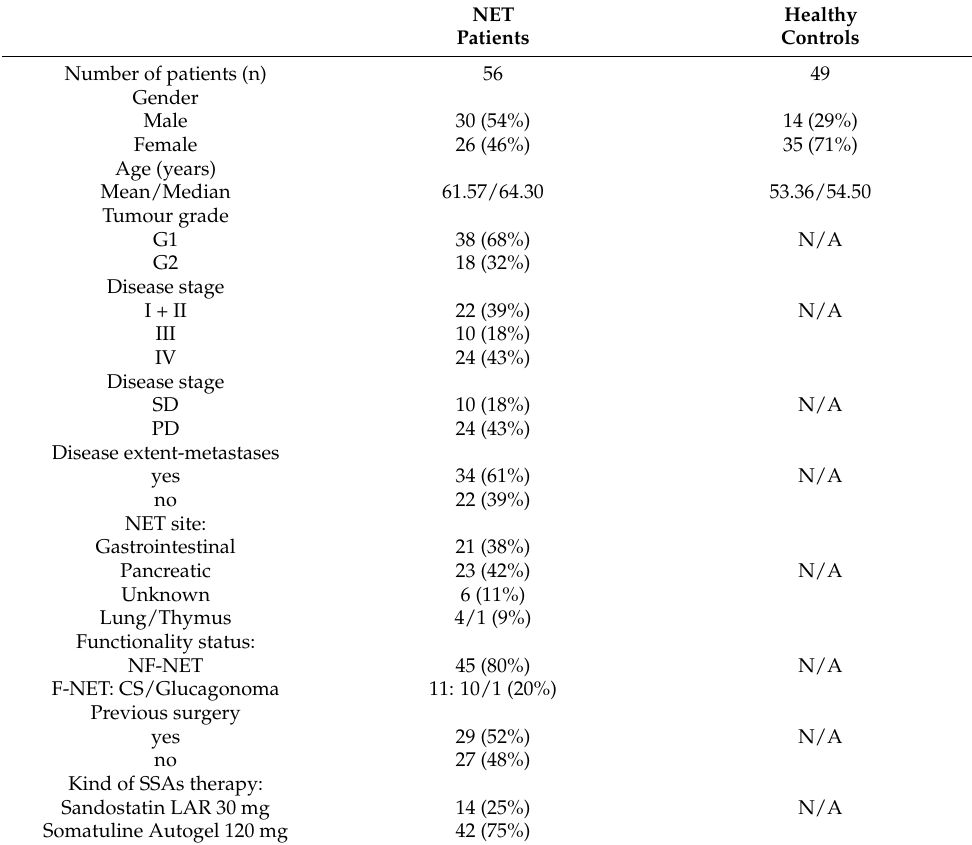
Table 1. Characteristics of the neuroendocrine tumor (NET) patients and the healthy